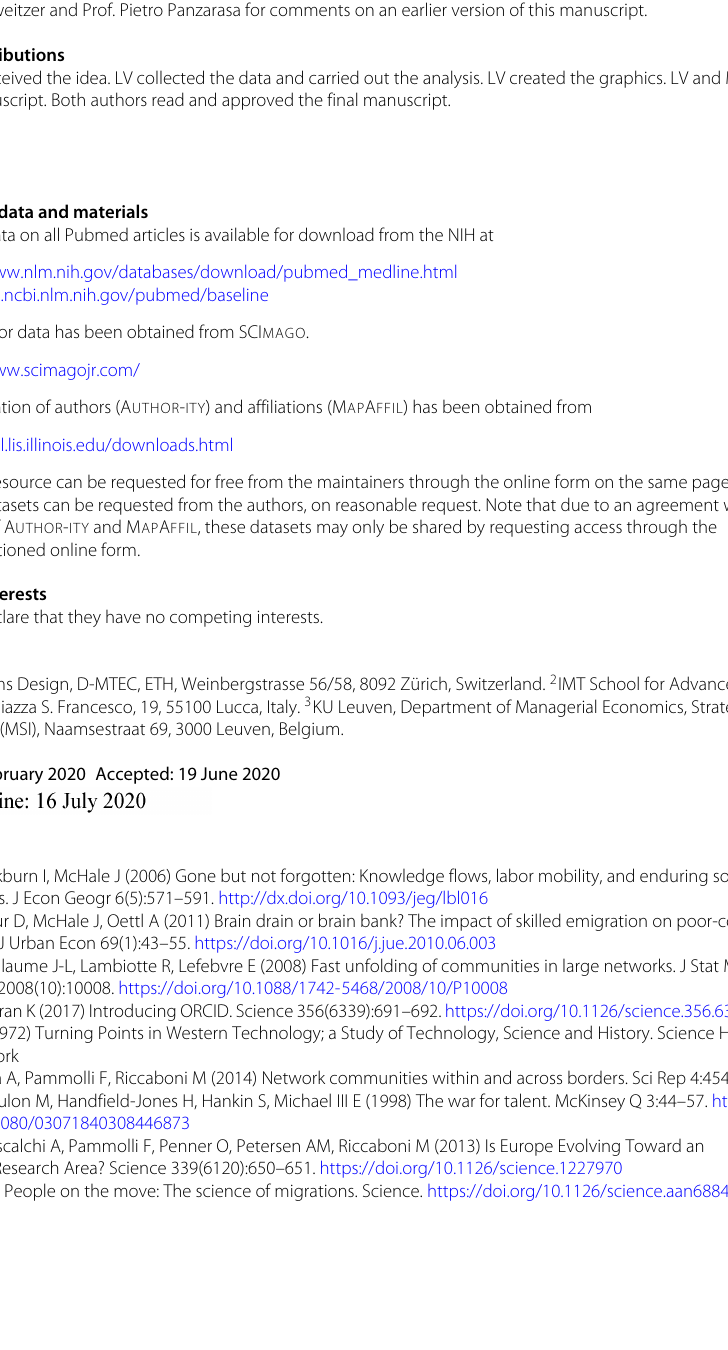
Table 4 Breakdown of communities by country. For each modularity class the number of cities belonging to a country are listed along with their proportion of cities in the class. For example community 15 is composed of 25% Swedish, 22% Finnish, 20% Norwegian and 16% Danish cities as well as 17% smaller cities. Note: only countries with at least 5% member cities are listed ( Continued ) Community ( x ) Country ( c ) % of cities of c in x No. Cities 30 USA 83% 84 31 Nigeria 47% 34 South Africa 39% 28 32 India 73% 122 USA 8%